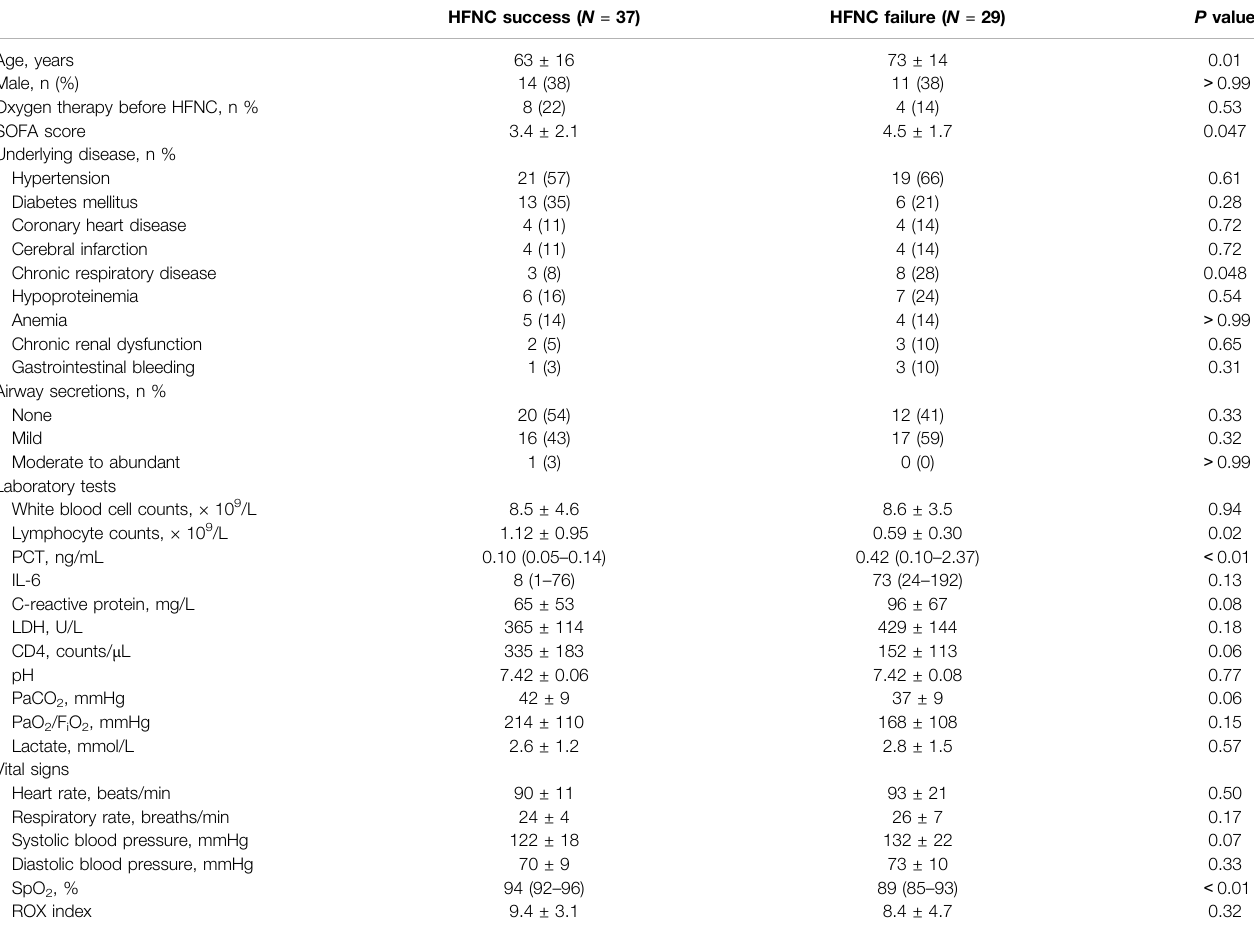
TABLE 1 | Baseline data collected before the use of